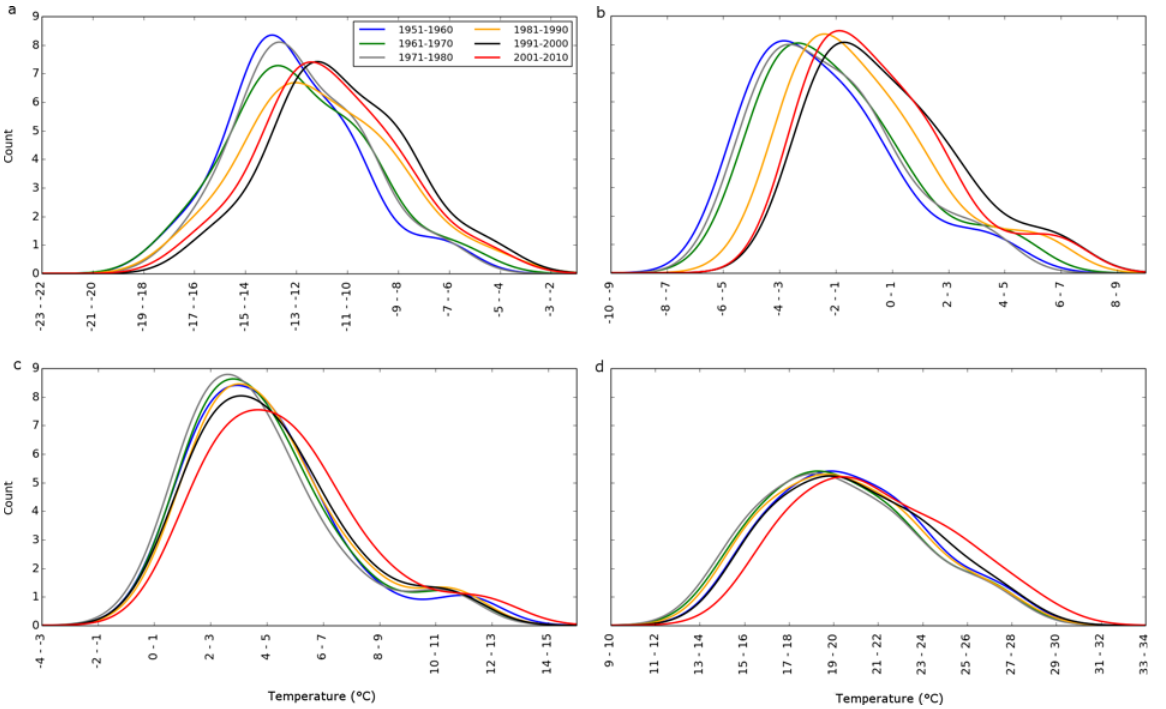
Fig 6. Decadal distributions of minimum (a, c) and maximum (b, d) Winter (a, b) and Summer (c, d) temperatures using the modeled SNOTEL + COOP data, 1950 – 2010. Distributions were smoothed using kernel density estimators.